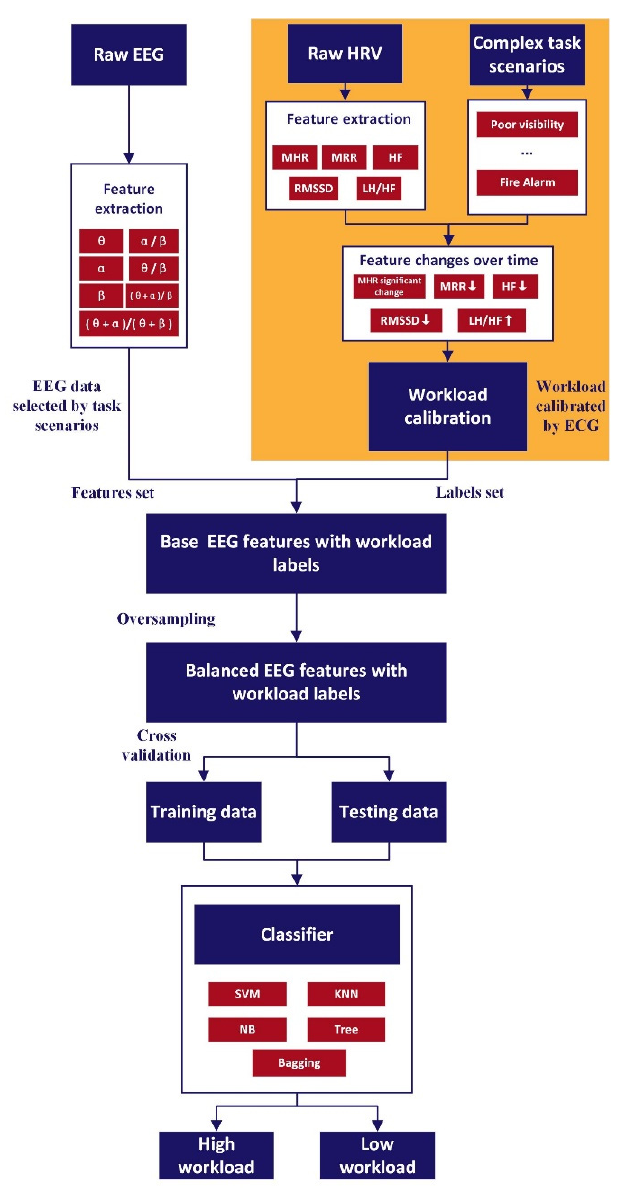
Figure 9. Improved seafarers’ workload recognition algorithm framework.